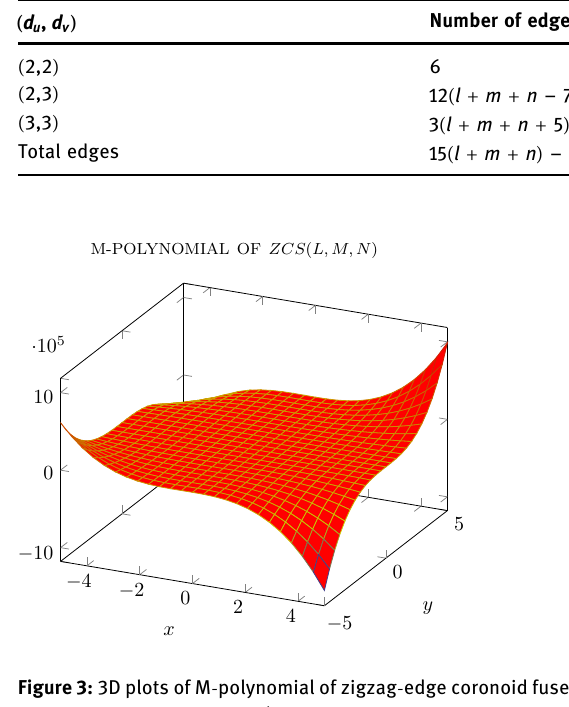
Figure 3: 3D plots of M - polynomial of zigzag - edge coronoid fused by